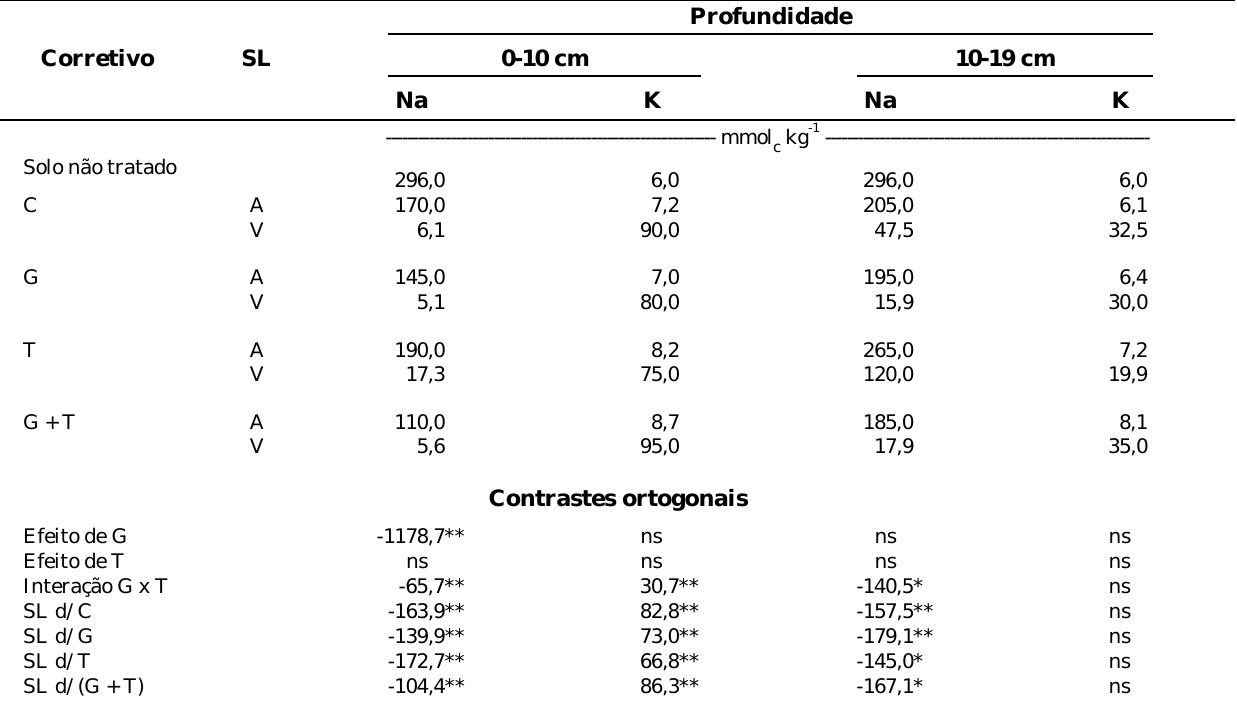
Quadro 2. Sódio e potássio trocáveis após a correção do solo, considerando a profundidade de amostragem, o corretivo e a solução de lixiviação (SL)